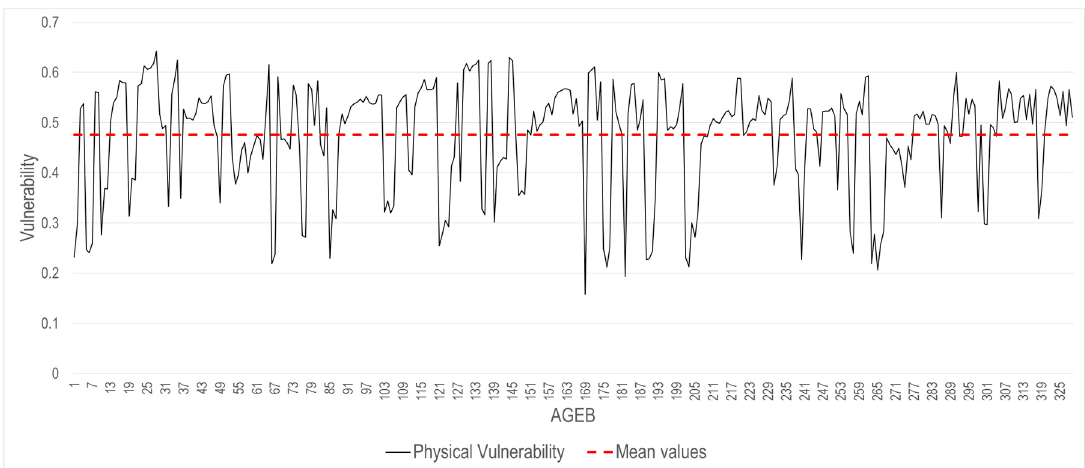
Figure 7. Physical vulnerability values for the studied AGEB.